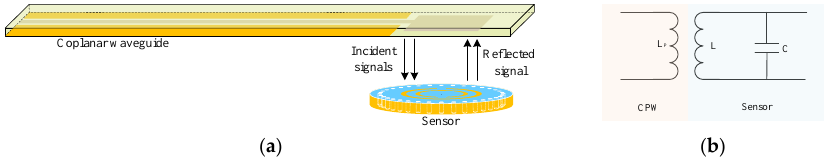
Figure 5. ( a ) Wireless passive sensor model, ( b ) simplified equivalent circuit diagram.